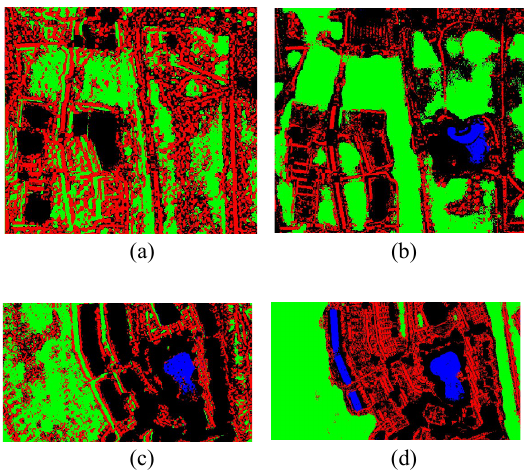
Figure 2. Red = buildings ( Huang, Zhang, 2011; 2017b), Green = Vegetation (Panagiotopoulou, Ragia, 2021 Blue = water ( Panagiotopoulou, Ragia, 2021 (e.g., soil and roads): Multiindex urban representation of (a) QuickBird image of “Scene 1” (b) WorldView image of “Scene 1” (c) QuickBird image of “Scene 2” (d) WorldView image of “Scene